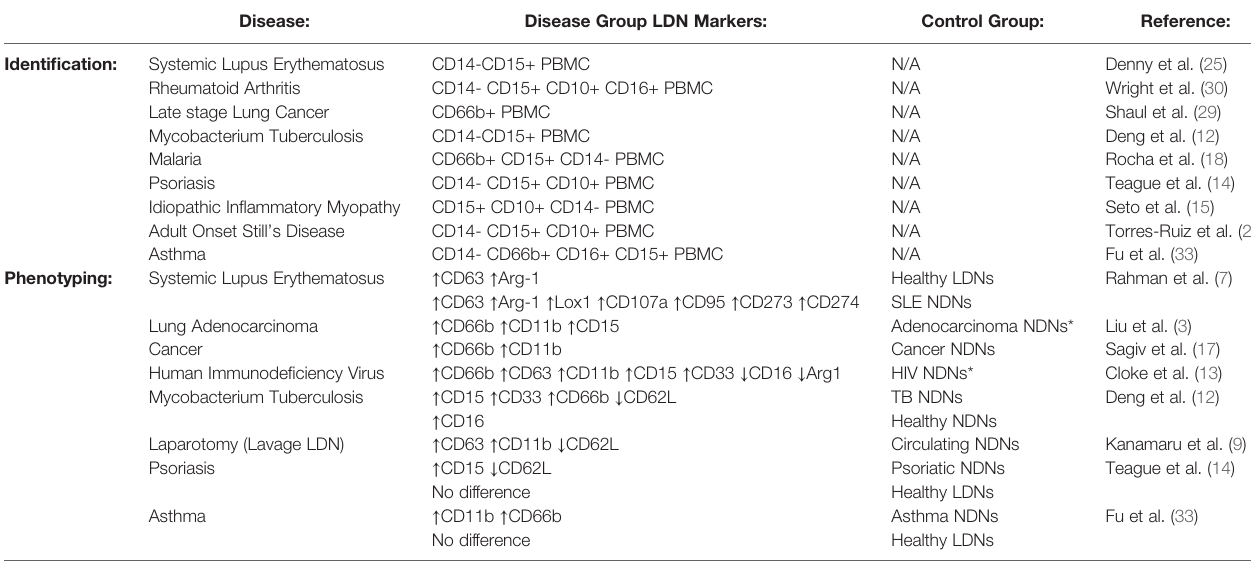
TABLE 1 | Overview of LDNs characterised by fl ow cytometry.